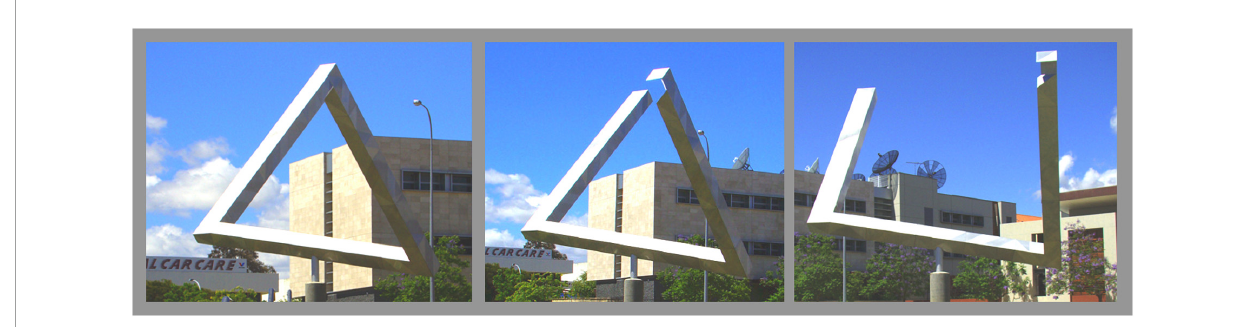
FIGURE8 A sculpture by Brian MacKay and Ahmad Abas in East Perth, Western Australia from three different viewpoints. In the left image, the structure looks like a Penrose triangle. One perceives an impossible structure, despite the existence of a real structure that yields the same retinal stimulation. This figure is based on pictures by Bjørn Christian Tørrissen (CC BY-SA 3.0).